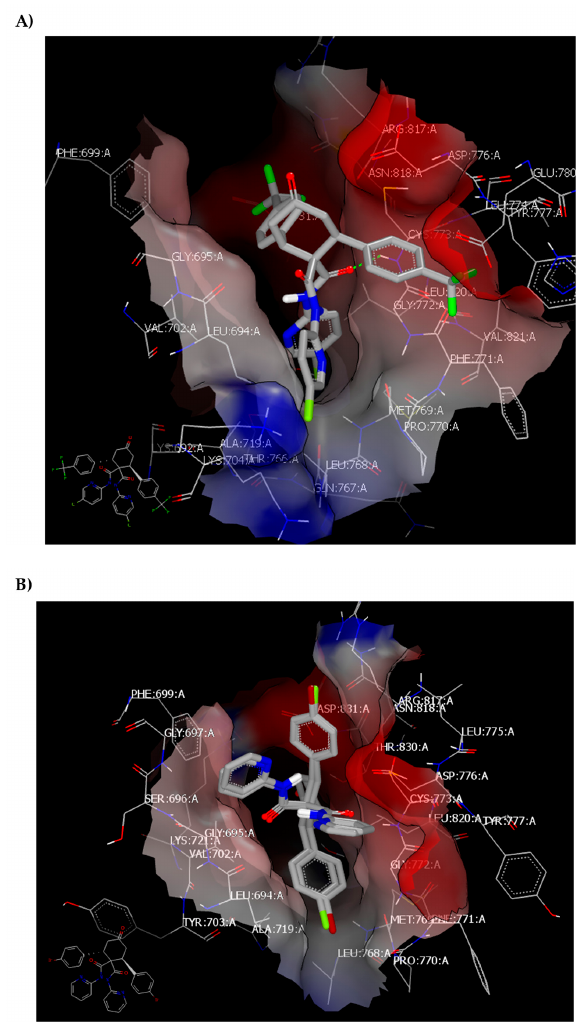
Figure 2. ( A ) Snapshot of 3l in ID:1M7 showing the HB interaction with Gly 772; ( B ) Snapshot of 3c and 3e (ID:1M17) overlaid on each other to show the hydrophobic–hydrophobic interactions.